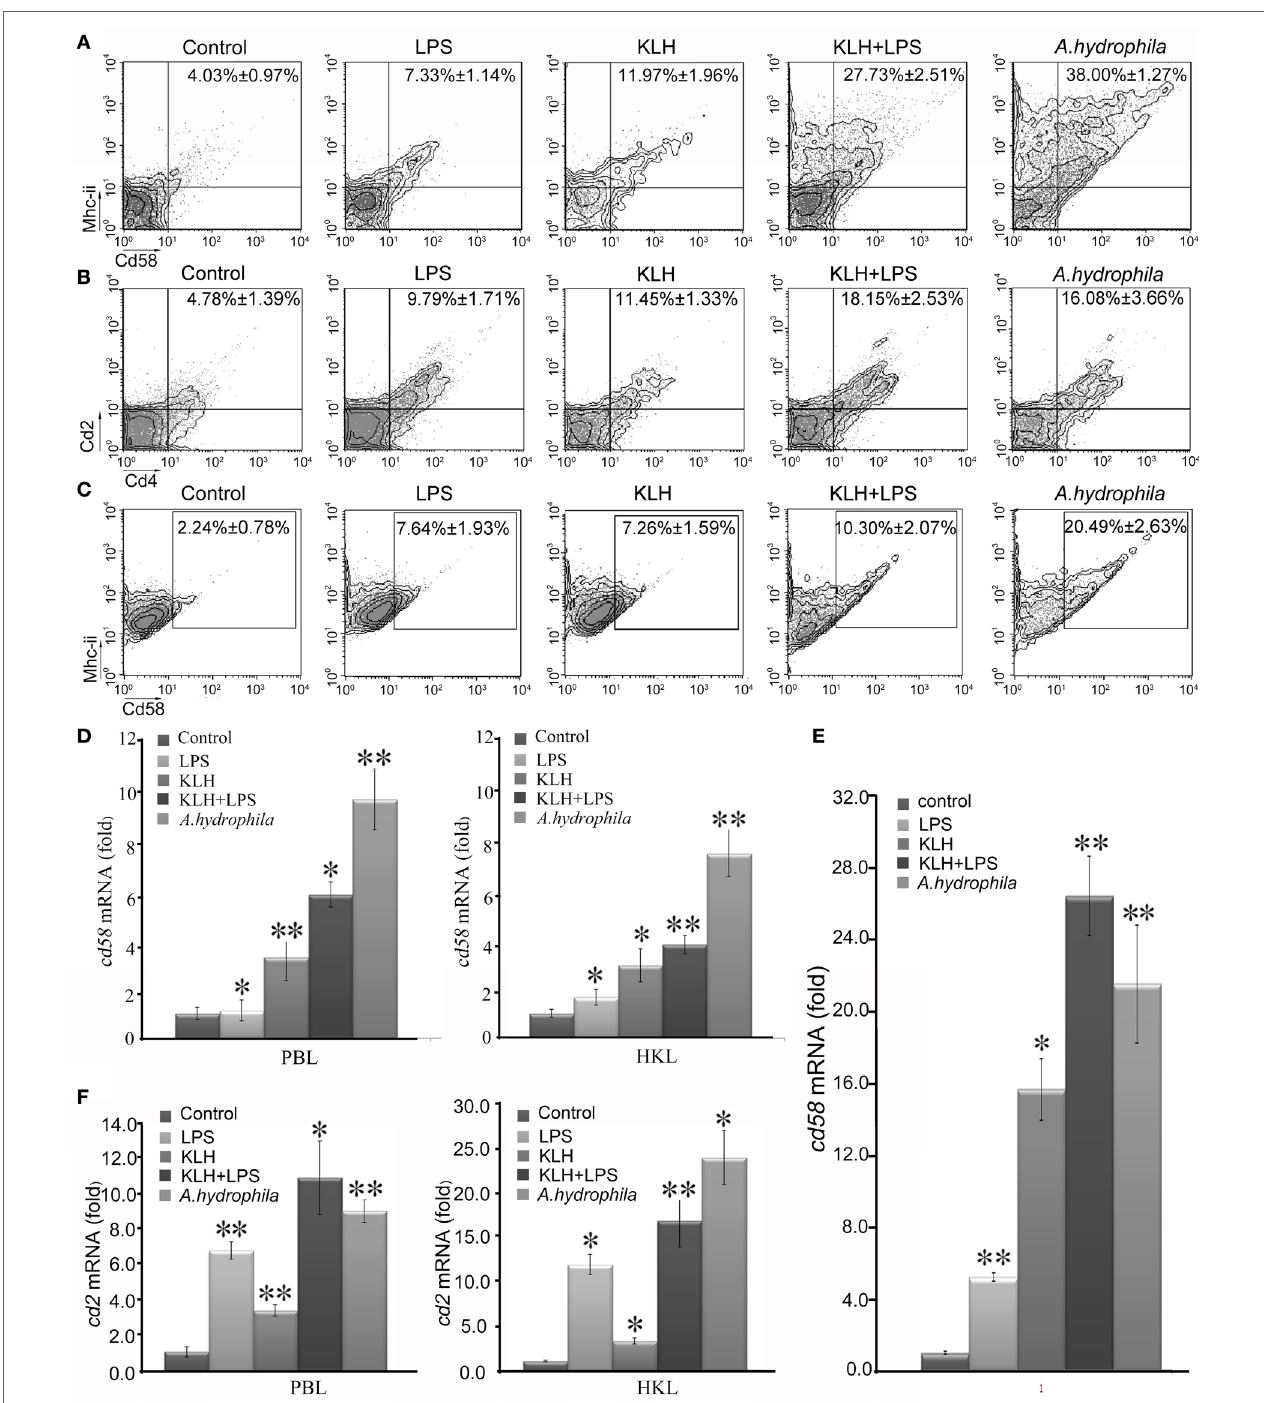
FigUre 6 | Induced expression analysis of cd58 and cd2 on APCs or Cd4 + T cells upon keyhole limpet hemocyanin (KLH) [plus lipopolysaccharide (LPS)] or Aeromonas hydrophila stimulations. (a,B) Flow cytometric analysis of Cd58 or Cd2 expression level on APCs or Cd4 + T cells, which were sorted from peripheral blood, spleen, and kidney tissues 3 days after i.p. stimulation with PBS, KLH, LPS, KLH plus LPS, or A . hydrophila . The numbers above the outlined areas indicate the percentage of double positive cells in each group. (c) Flow cytometric analysis of Cd58 + Mhc-ii + cells from sorted APCs upon pulsing with PBS, KLH, LPS, KLH plus LPS, or A . hydrophila for 8 h in vitro . The numbers above the outlined areas indicate the percentage of double positive cells in each group. Means ± SE of results from three independent experiments are shown (* p < 0.05, ** p < 0.01). (D) Real-time PCR analysis for the expression of Cd58 in APCs of each in vivo treatment group. (e) Real-time PCR analysis for the expression of cd58 in APCs with in vitro treatment of PBS, KLH, LPS, KLH plus LPS, or A . hydrophila . (F) Real-time PCR analysis for the expression of cd2 in Cd4 + T cells of each in vivo treatment group. The relative expression values were averaged from the data in three parallel reactions, and the results were obtained from at least three independent experiments (* p < 0.05, ** p <